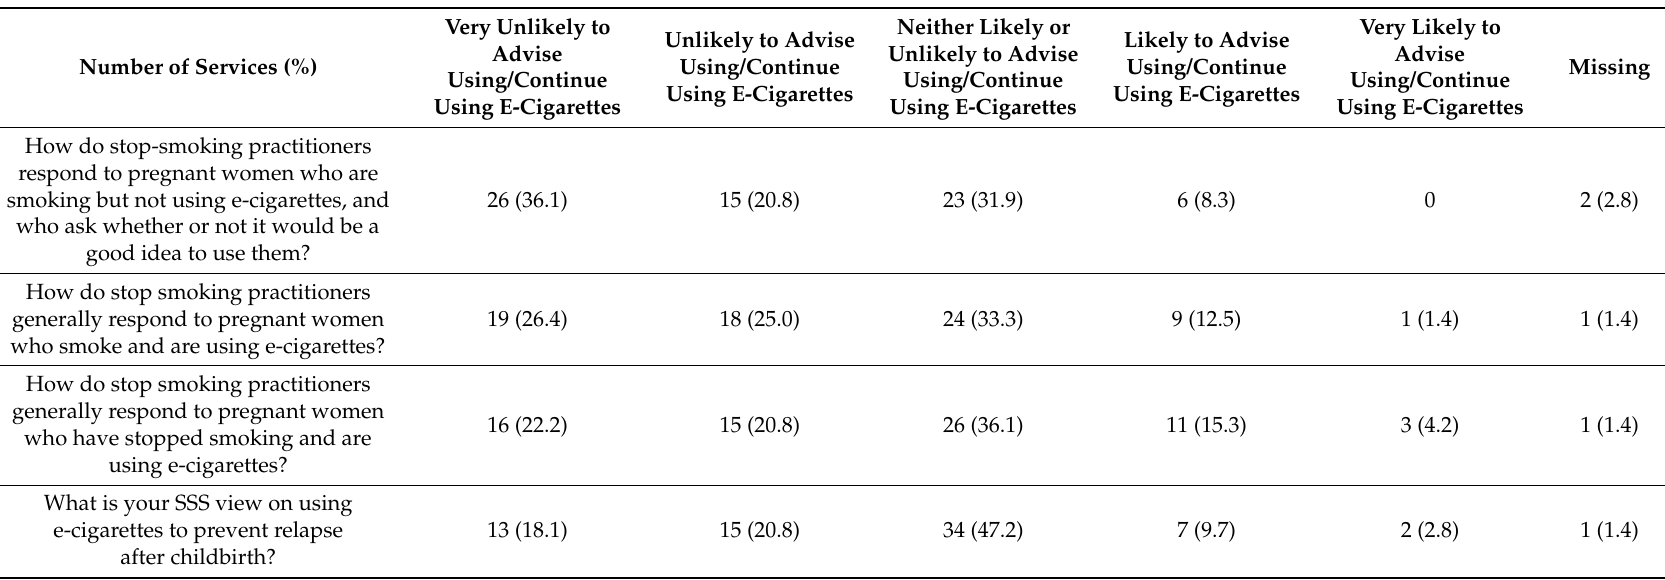
Table 2. E-cigarette advice given by pregnancy stop smoking practitioners: responses to different scenarios in pregnancy and postpartum. Number of Services (%)